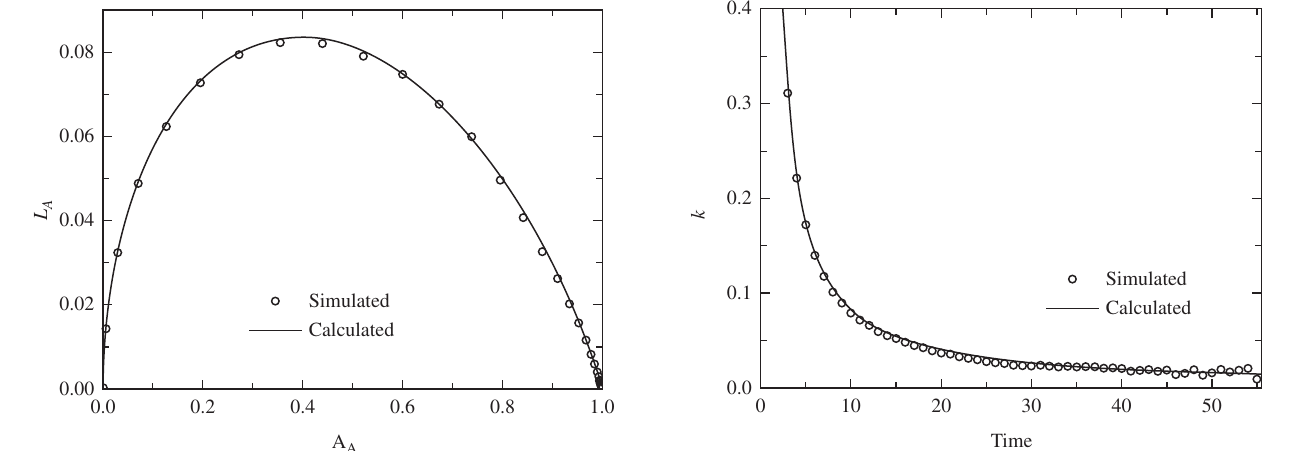
Figure 3. Microstructural path: length of the interface between transformed and untransformed region per unit of area, L Simulation results are in agreement with those calculated from the kinetics of a single grain, Equation 15.